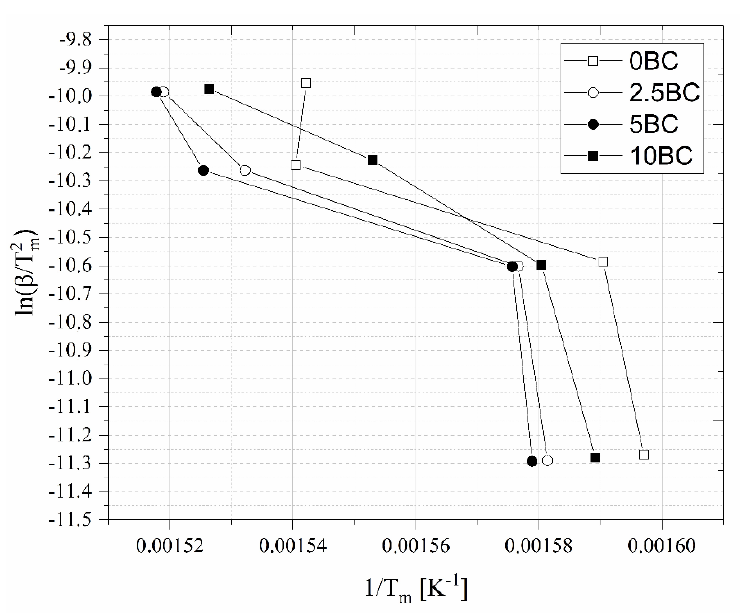
Figure 10. Kissinger plots of investigated composite in nitrogen. Table 6. Kissinger data of investigated composite in nitrogen.